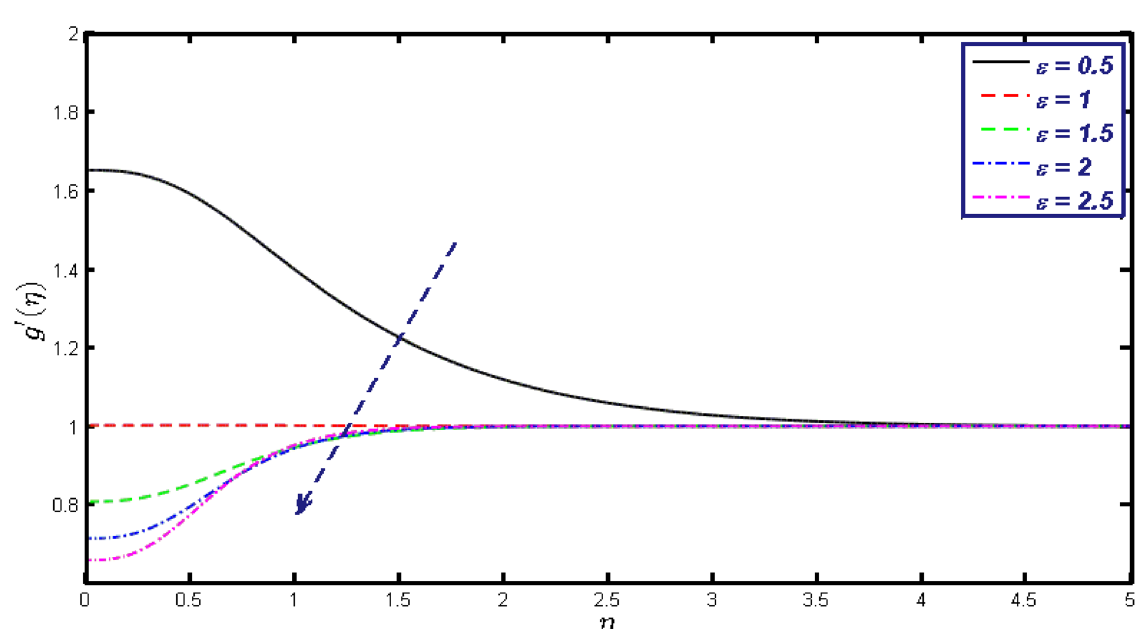
Figure 20. g ′ (η) field for distinct values of ε